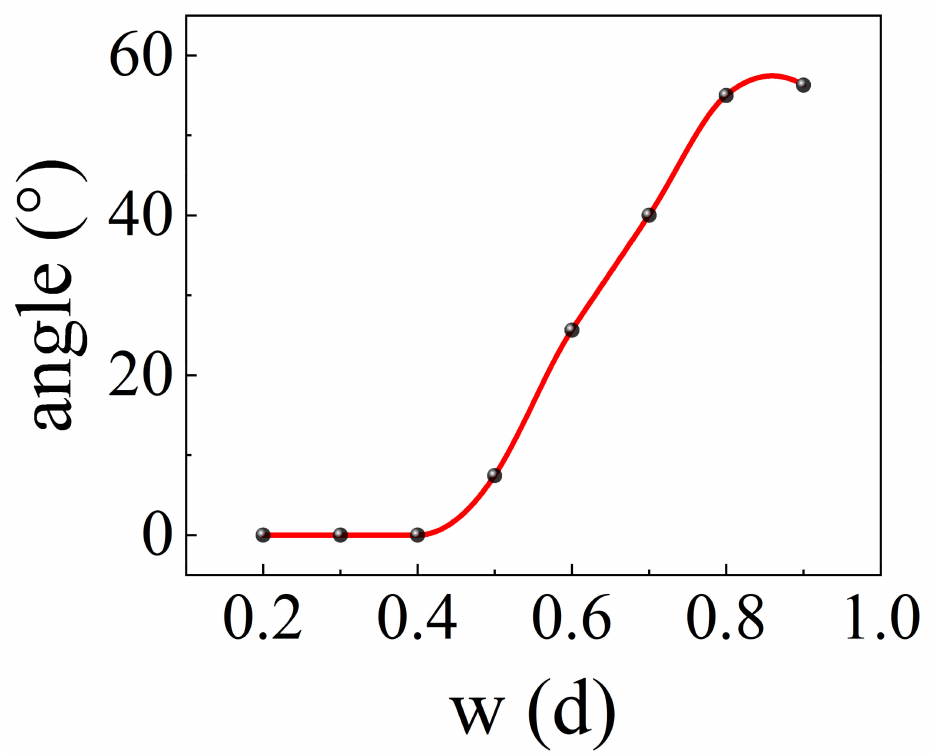
Figure 7. The relationship between the tilt angle of the phase singularity trace in the z-polarized component of the focused field and the incident spatial waist radius. The d in the horizontal axis represents the pupil radius of the high NA